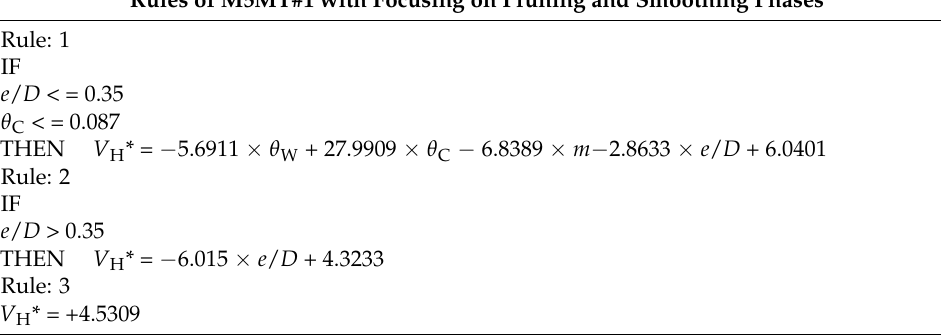
Table 8. Lists of M5MT details in V H * estimates. Rules of M5MT#1 with Focusing on Pruning and Smoothing